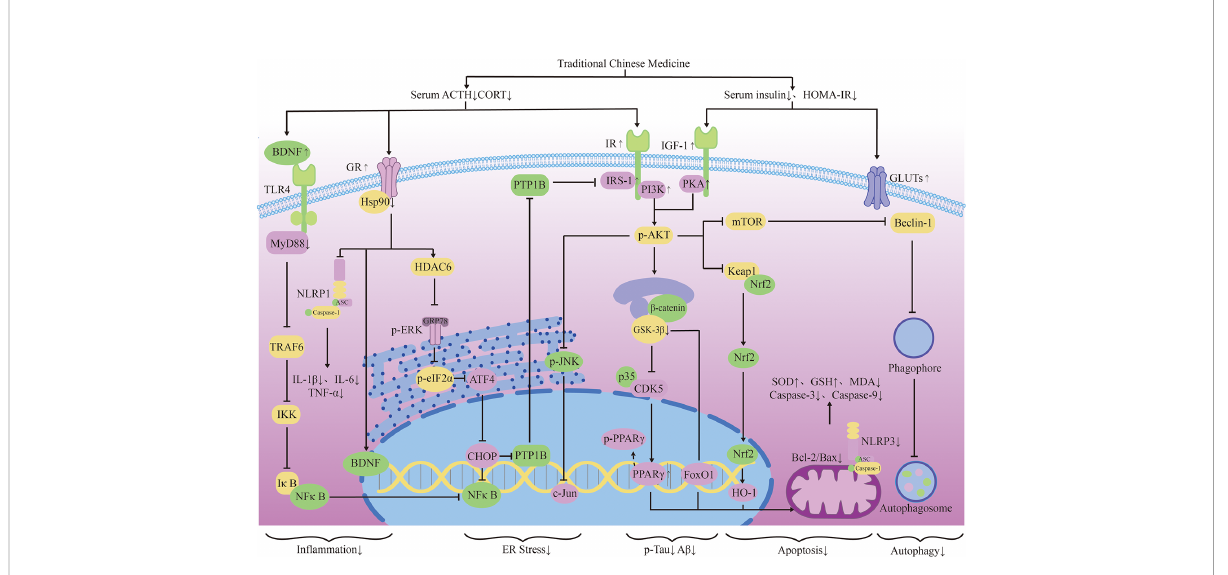
FIGURE 2 The neuroendocrine mechanism of TCM regulating HPA axis and insulin signal